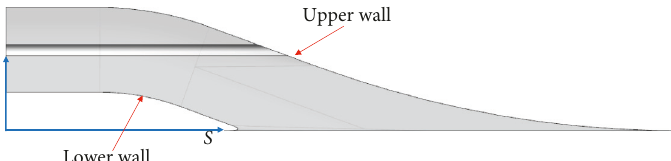
Figure 13: Sketch of the middle section of the inlet